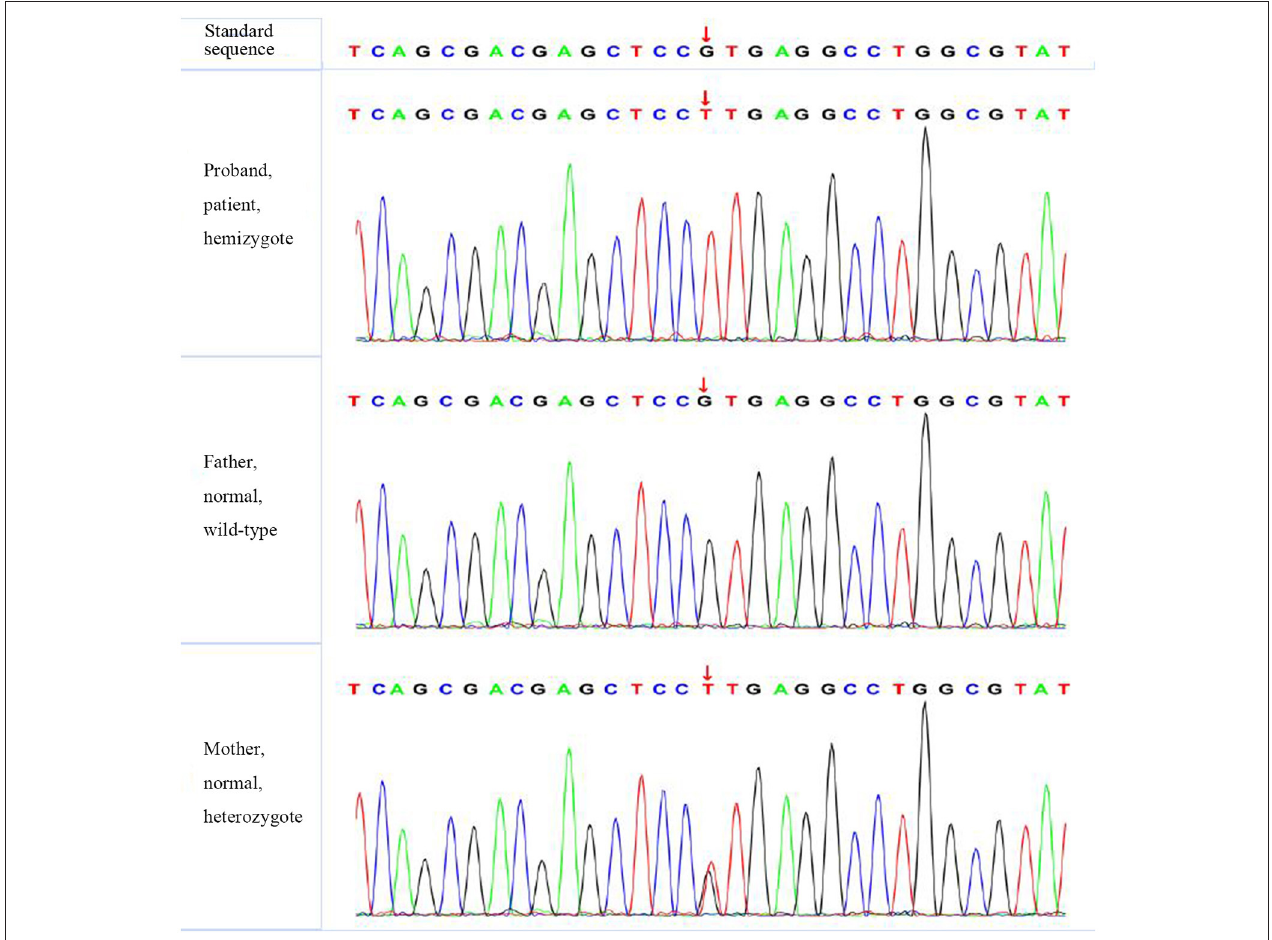
FIGURE 3 | The verification results of G6PD . G6PD :c.1466 (exon 12) G > T.